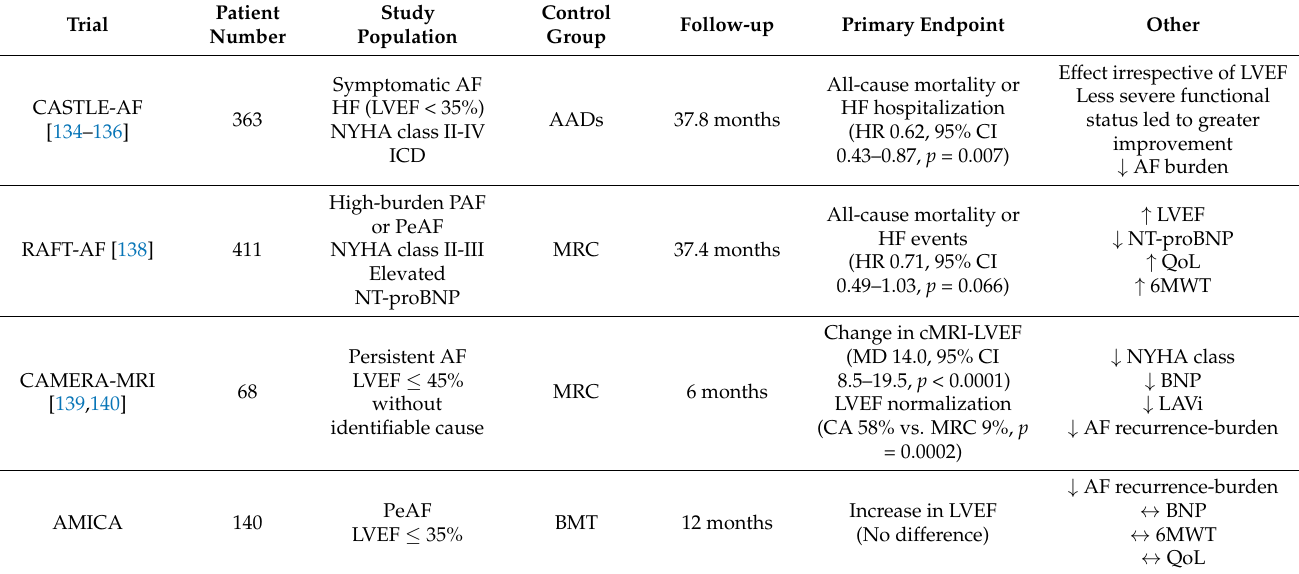
Table 1. Landmark randomized clinical trials in patients with atrial fibrillation (AF) and heart failure